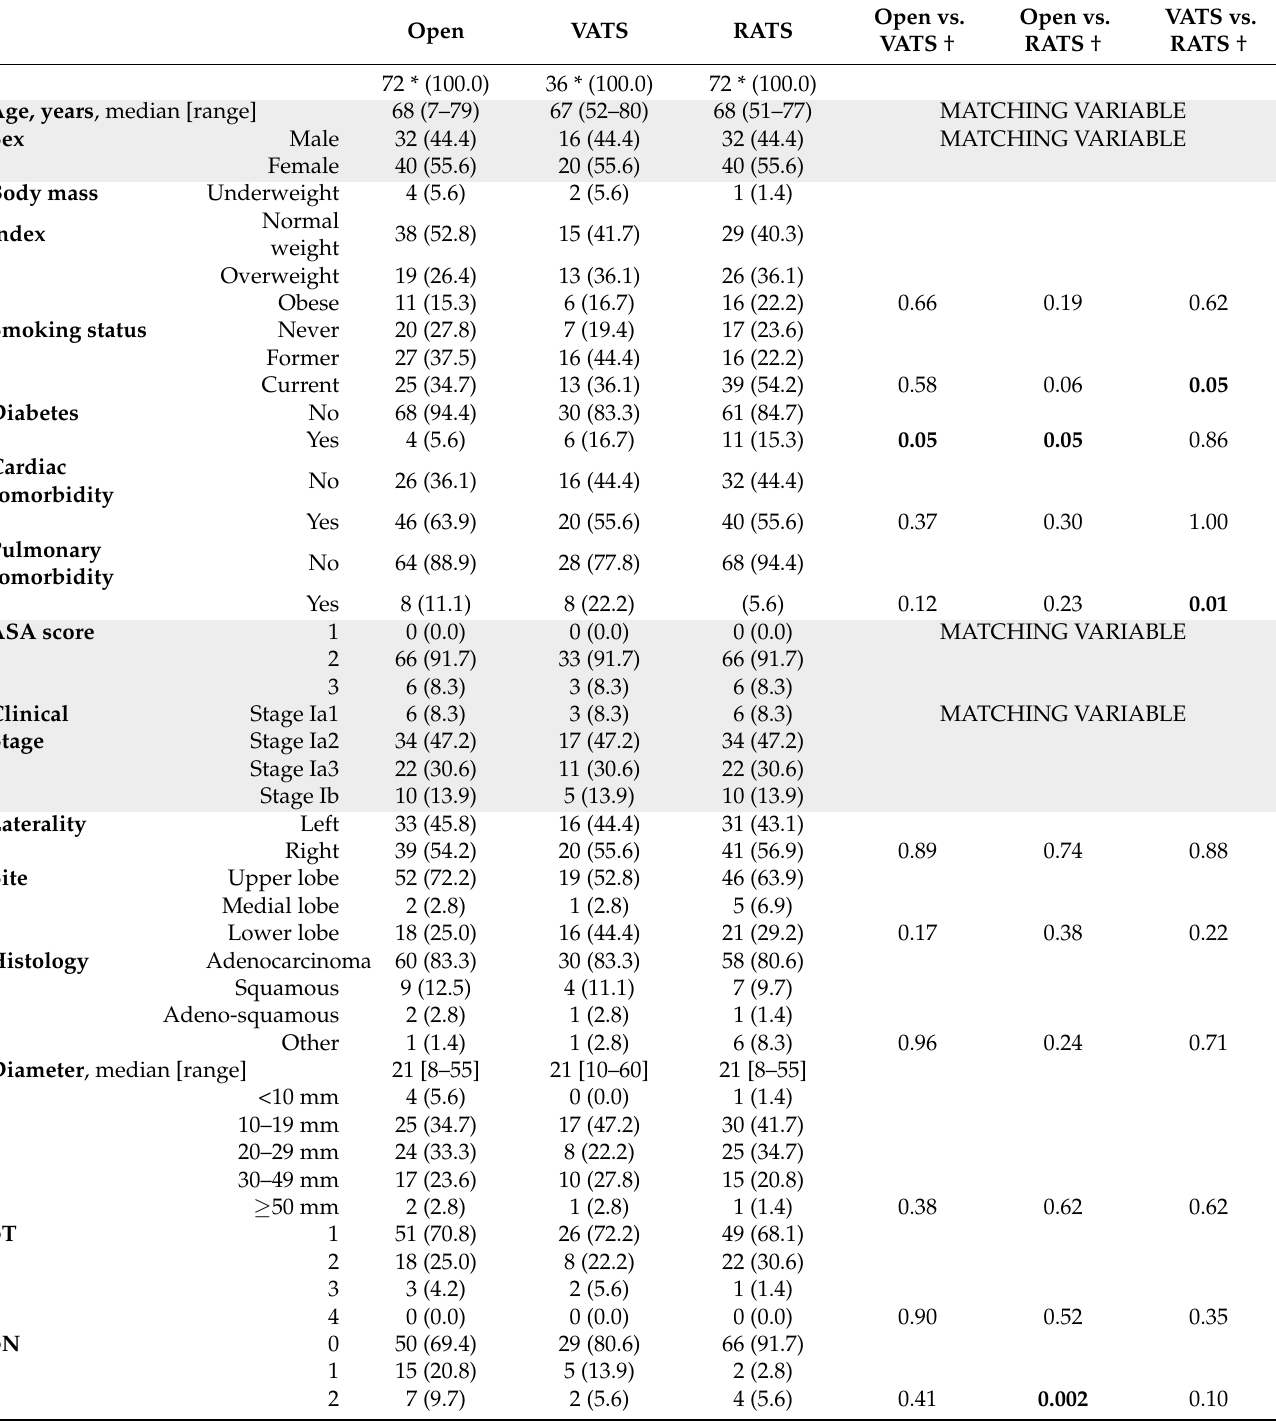
Table 1. Patients’